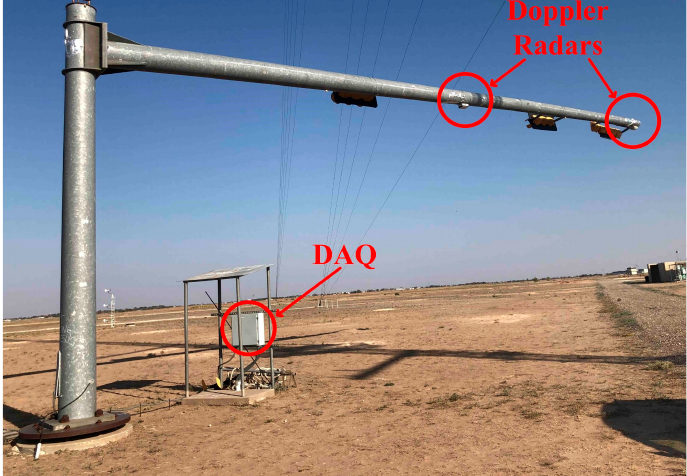
Figure 10. Experimental setup. The low-cost Doppler radar array and the data acquisition instru- mentation are highlighted [72].